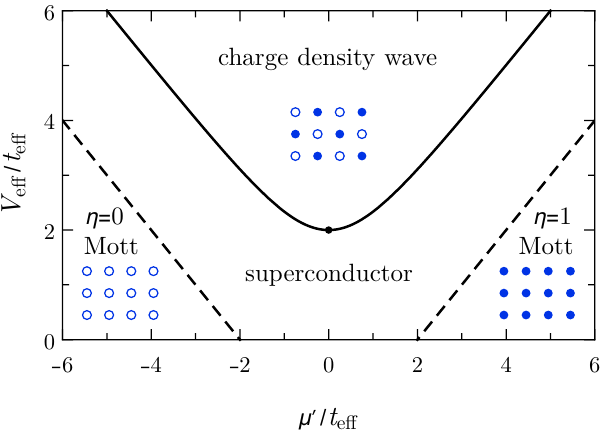
Figure 3: A phase diagram of the hard-core boson model [ Eq. (8) ] extracted from Ref. [ 67 ] . A large boson chemical potential µ (cid:48) results in a Mott insulating phase with boson number η = 0 or η = 1 on every site. A large boson repulsion V induces a charge density wave where half of the hard-core boson states are filled in a checkerboard pattern. In between these phases is a superconducting phase. The fermion model [ Eq. (6) ] results in V dashed lines are continuous, while the transition across the solid line is discontinuous [ 68 ] . (There is a hidden SU ( 2 ) symmetry when µ (cid:48) = 0 and V